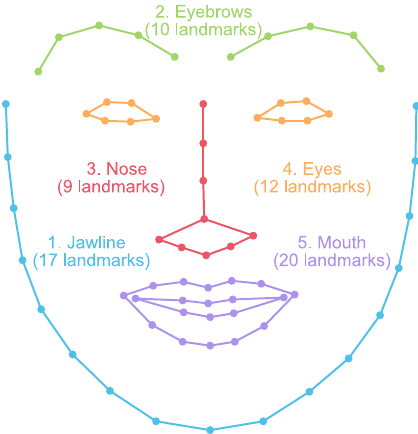
Figure 3. Facial landmarks detected by